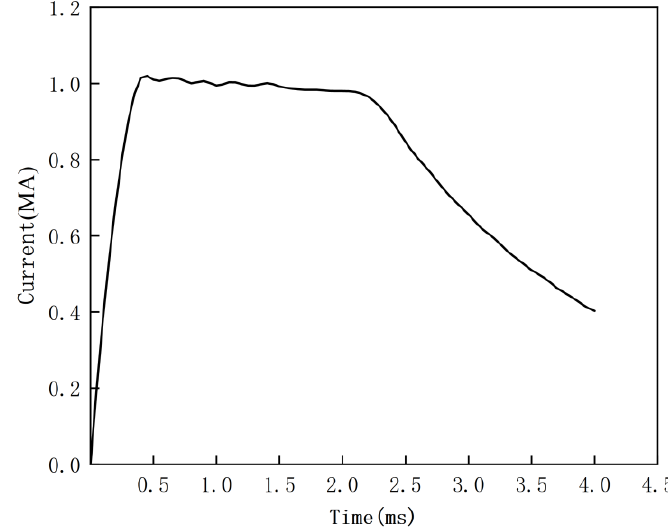
Figure 15. Waveform diagram of excitation current in case 2.